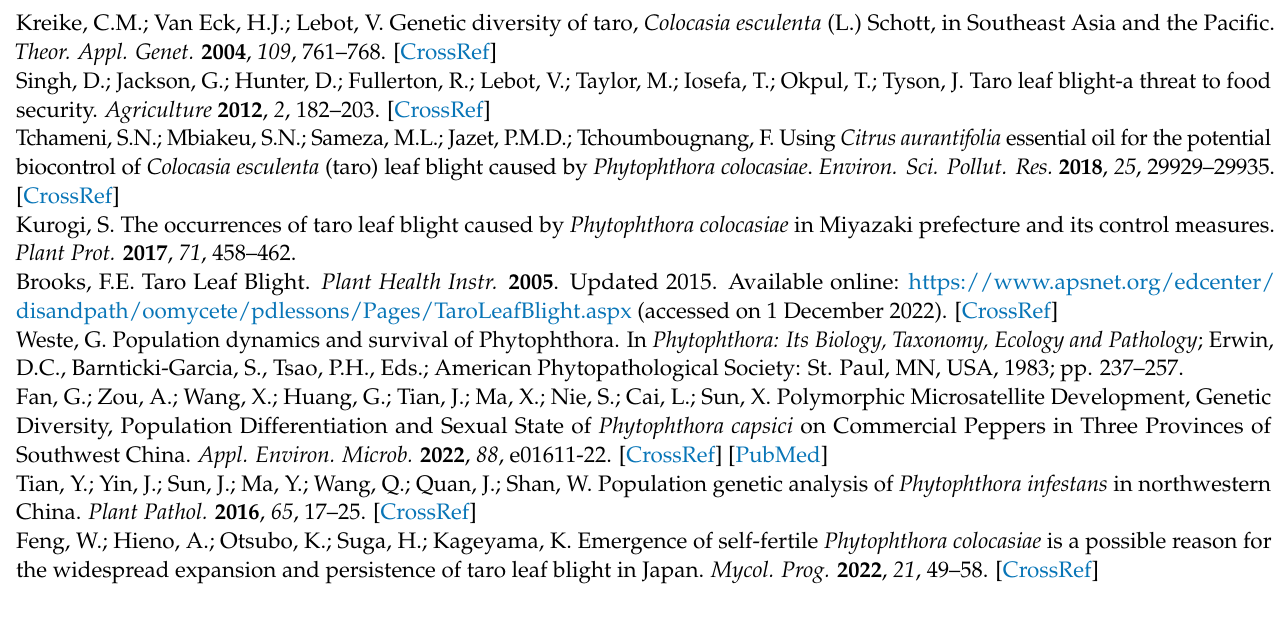
marker development; Figure S2: PCA plot generated by the R package “polysat”; Table S1: List of the tested isolates of Phytophthora colocasiae ; Table S2: Genotypes in each population from 2014 to 2020; Table S3: Mating types of Phytophthora colocasiae and their corresponding genotypes in each population; Table S4: Ploidy level of Phytophthora colocasiae and their corresponding genotypes in each